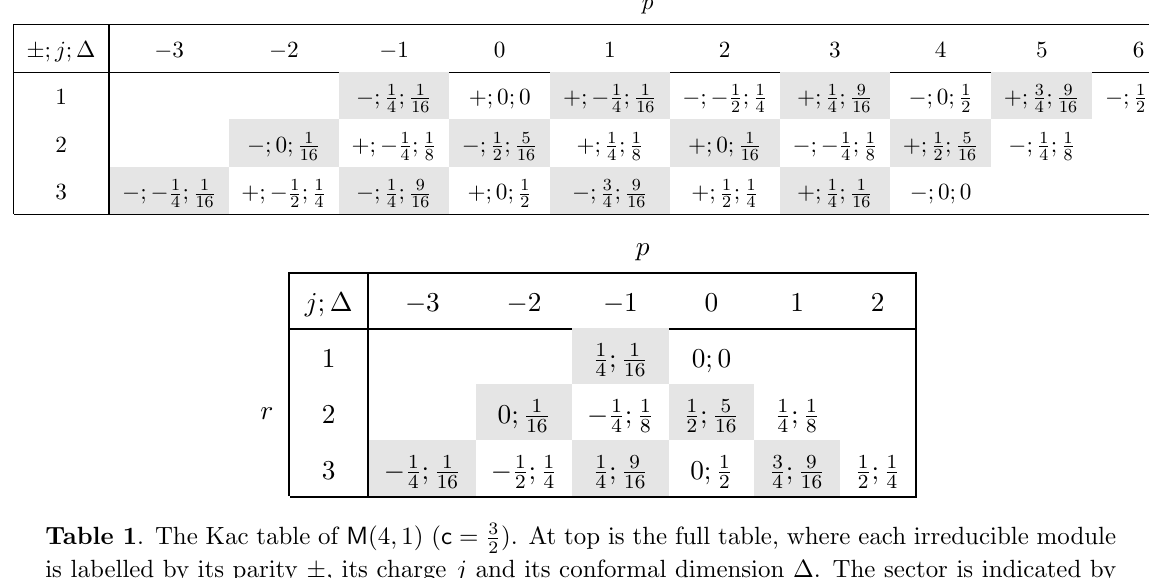
shading Ramond cells. At bottom is a simpli(cid:12)ed Kac table in which parity is ignored and the \Kac symmetry" (4.6) is used to remove half the modules. The charges and conformal dimensions in this pyramidal table are computed using